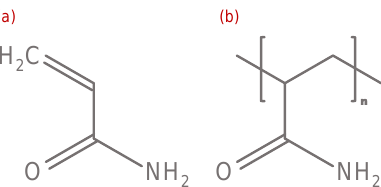
Figure 1. ( a ) Acrylamide monomer used for polymerization of polyacrylamides (PAMs) (modified after Lentz et al. [39]; ( b ) PAM chain after polymerization (modified after Hotta et al. [40] .